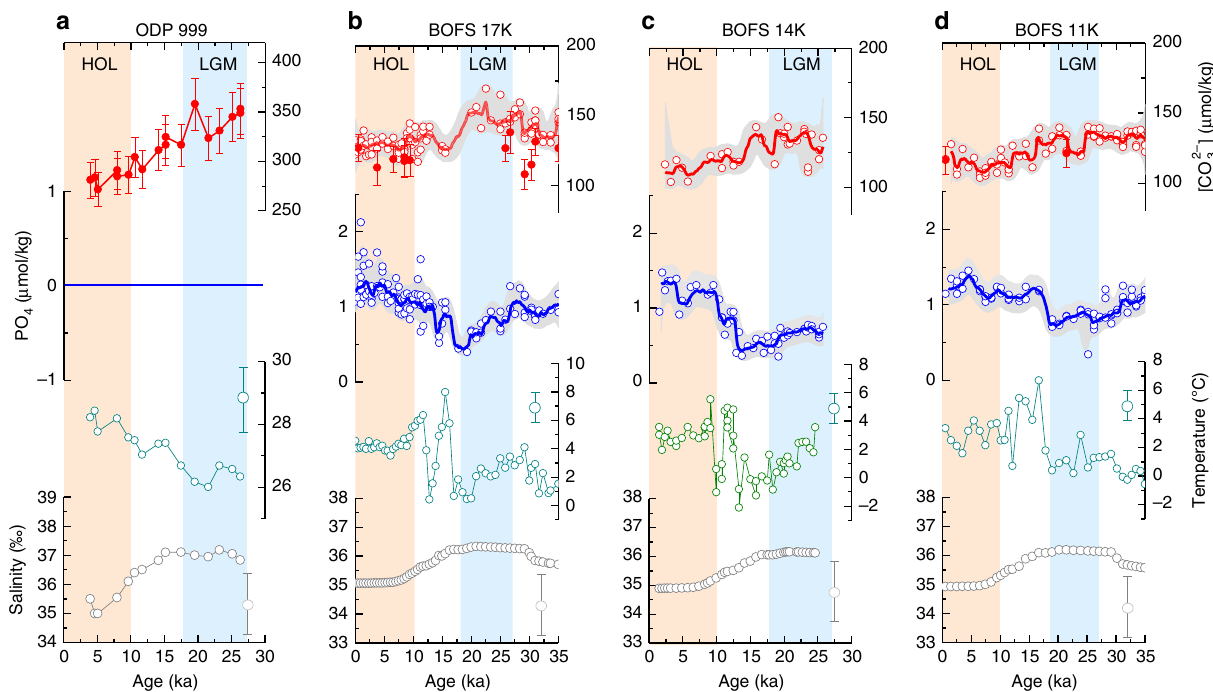
Fig. 3 Down core reconstructions. a ODP 999. b BOFS 17 K. c BOFS 14 K. d BOFS 11 K. Seawater [CO 3 2 − ] values are derived from benthic B/Ca (empty circles) and δ 11 B (solid circles). Light gray envelopes and error bars: 2 σ . Note different y -scales for surface- (ODP 999) and deep-water (BOFS